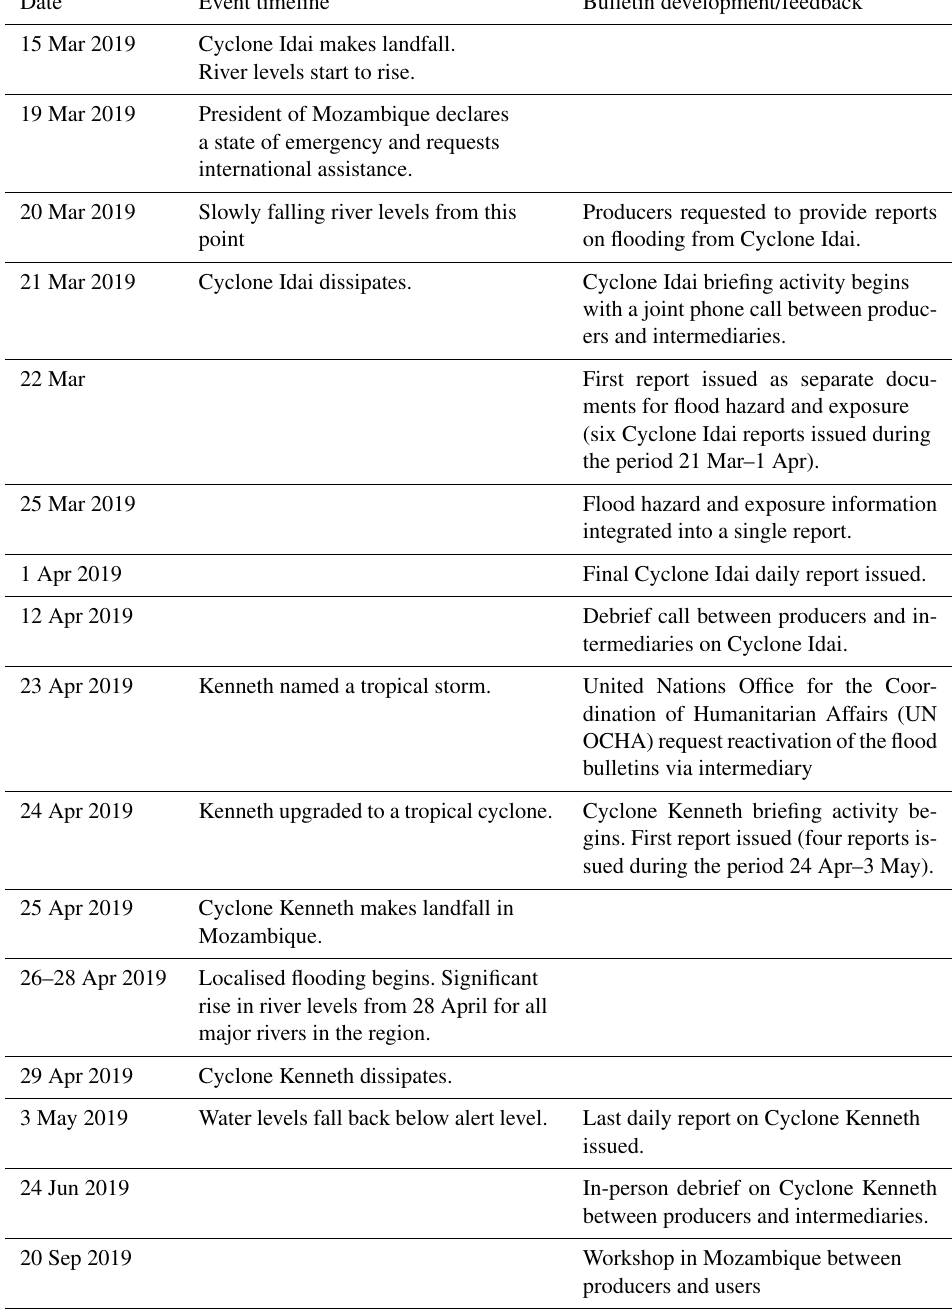
Table 2. Timeline and sources of feedback for the cyclone bulletin development. Note that, between each report issued, feedback and edits were made between intermediaries and